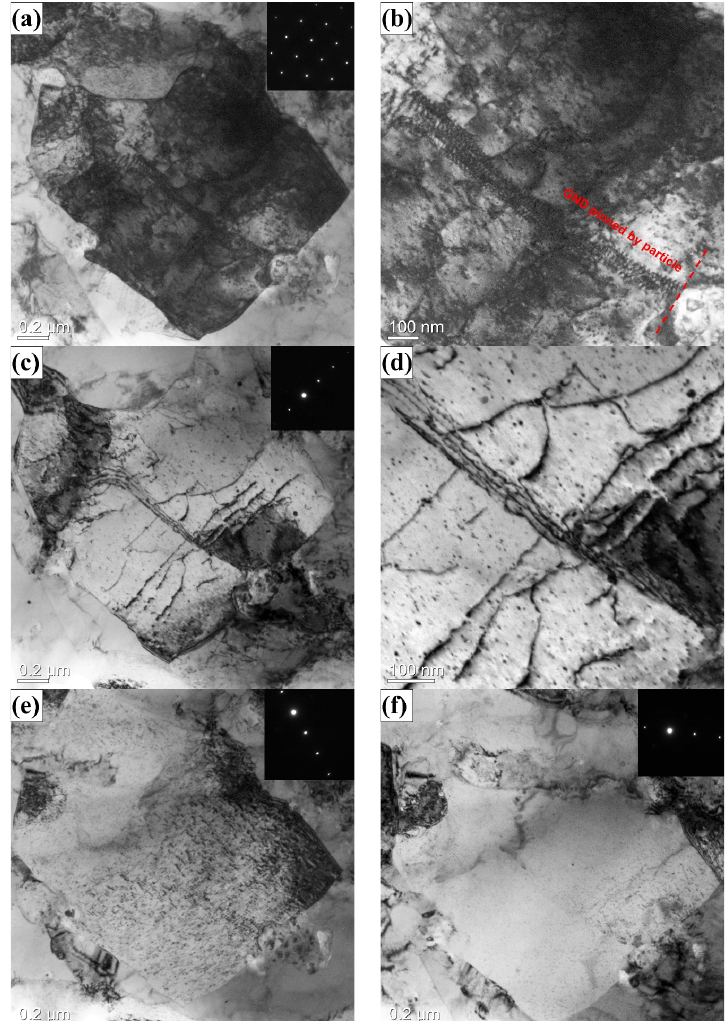
Figure 7. ( a , b ) BF images of alloy annealed at 800 ° C with high-density dislocations; ( c , d ) BF images with g = (11-1); ( e ) BF images with g = (1-11); ( f ) BF images with g =